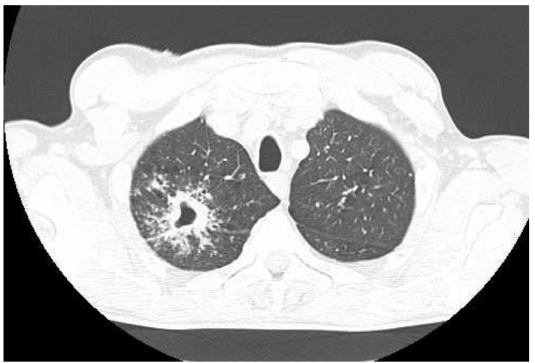
Figure 1. CT scan of the chest taken at the emergency department on admission to hospital in May 2021.